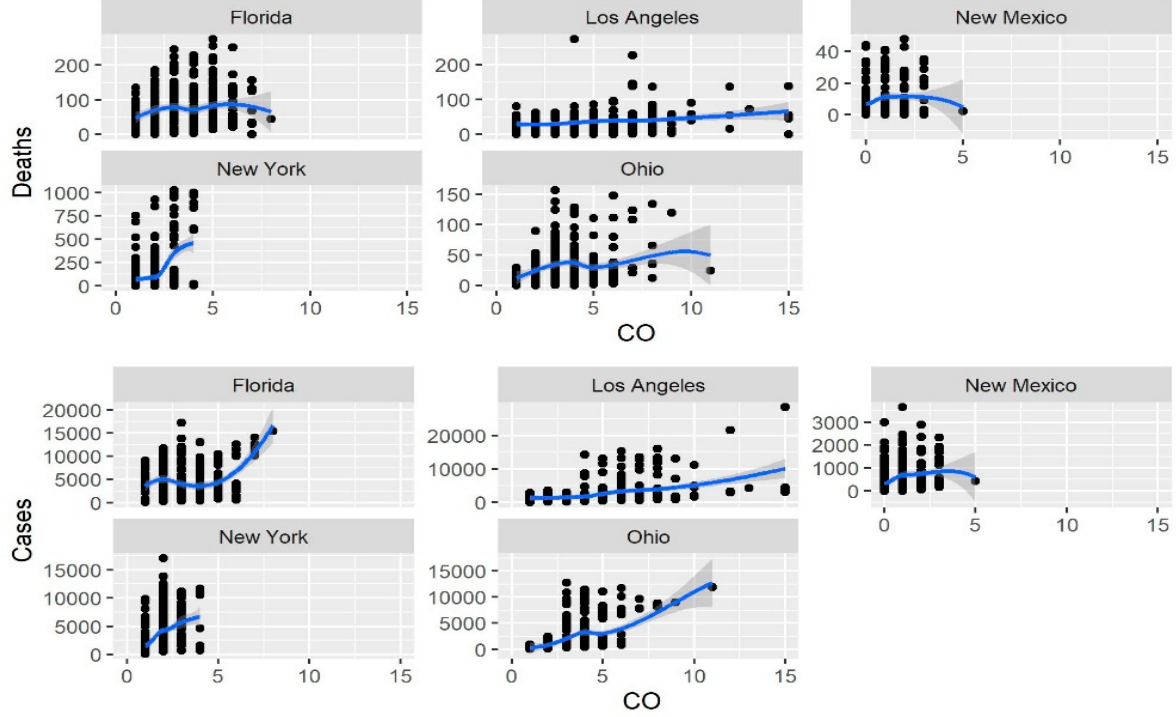
Figure 6. Relationship of the CO concentration with the number of new daily cases and deaths.